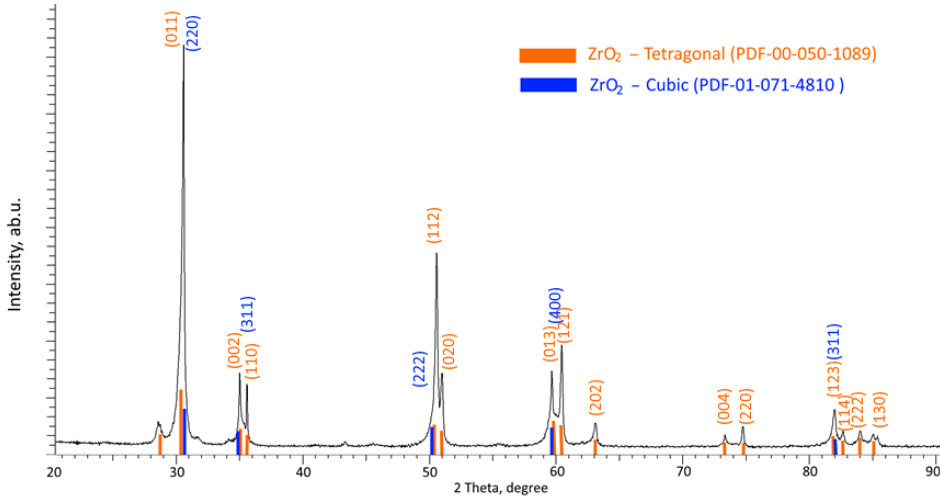
Figure 3. X-ray diffraction pattern of ZrO 2 ceramics in the initial state, reflecting the presence of a dominant tetragonal phase (t-ZrO 2 ) and an impurity cubic phase (c-ZrO 2 ). Based on the obtained data of the crystal lattice parameters, the deformation factor was calculated, which reflects the deviation of the crystal lattice parameters from the reference values for characteristic structures. This deformation factor was calculated considering these parameters for the reference ZrO 2 phase, with a tetragonal crystal lat- tice a = 3.5910 Å , c = 5.1690 Å (PDF-00-050-1089). The deformation factor of the crystal lattice parameters were 0.79% for a and 1.24% for c , which was due to the processes of deformation of the structure during synthesis. At the same time, the differences in the deformation factor for different crystallographic axes indicated the presence of aniso